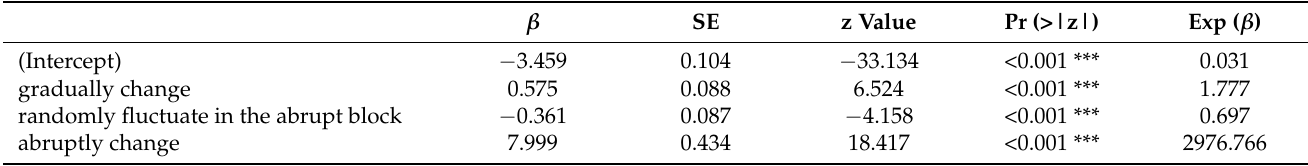
Table 6. The result of logistic regression.